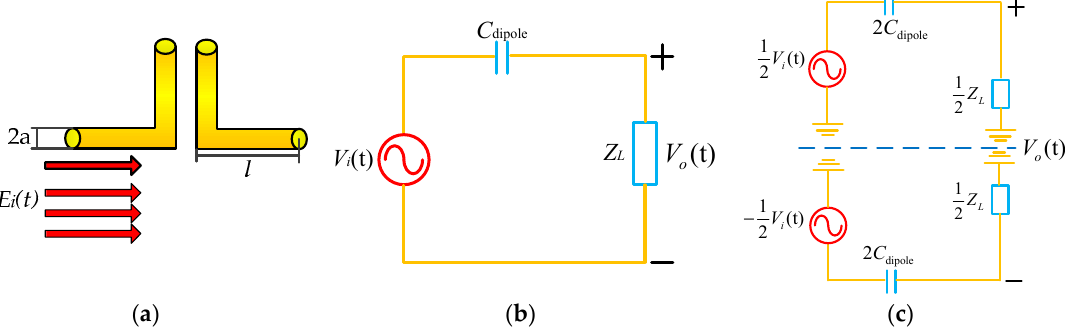
Figure 1. ( a ) Physical electric dipole. ( b ) Thevinin’s equivalent circuit model of an electric dipole when picking up a tangential electric-field component; ( b ) is the equivalent circuital form of ( c ) after applying odd/even-circuit analysis method.